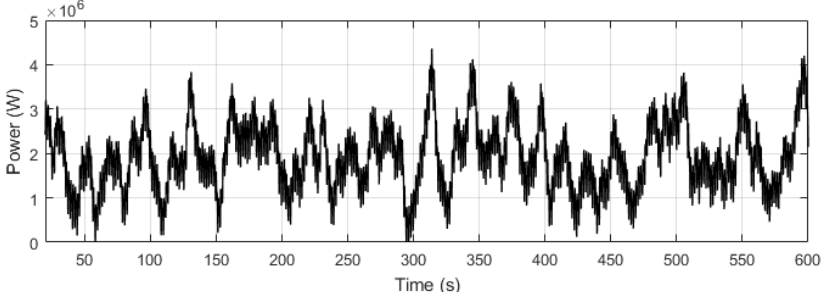
Figure 9. The fluctuation component.